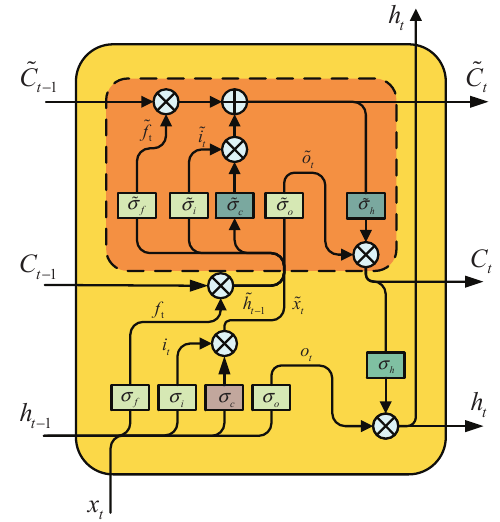
Figure 1. Structure of the NLSTM memory